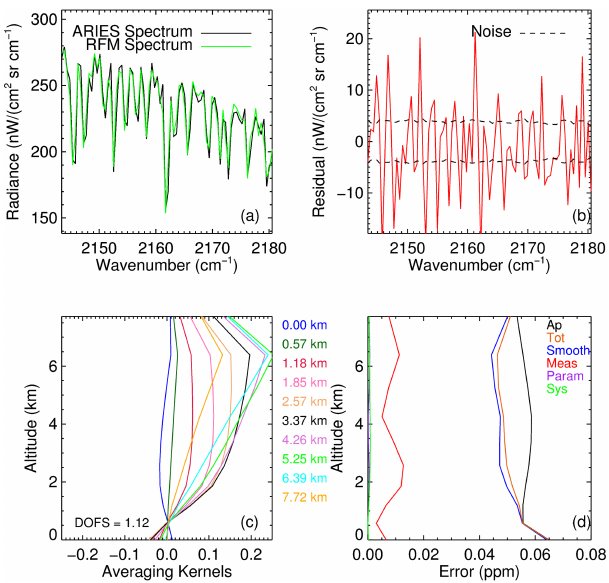
Figure 10. Example retrieval metrics for CO during flight B725 over land at 7.7km altitude showing (a) measured (ARIES) and fit- ted spectra, (b) residual difference between the ARIES-measured spectrum and fitted spectrum, (c) averaging kernels (and degrees of freedom, inset), and (d) total and component systematic and random error